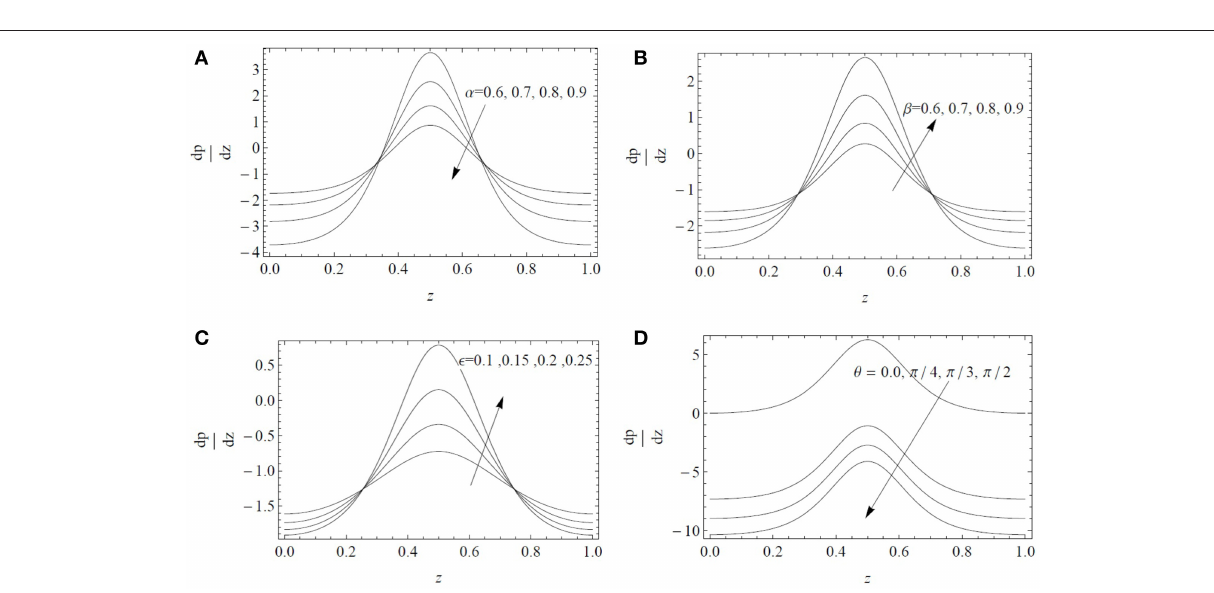
Frontiers in Physiology |